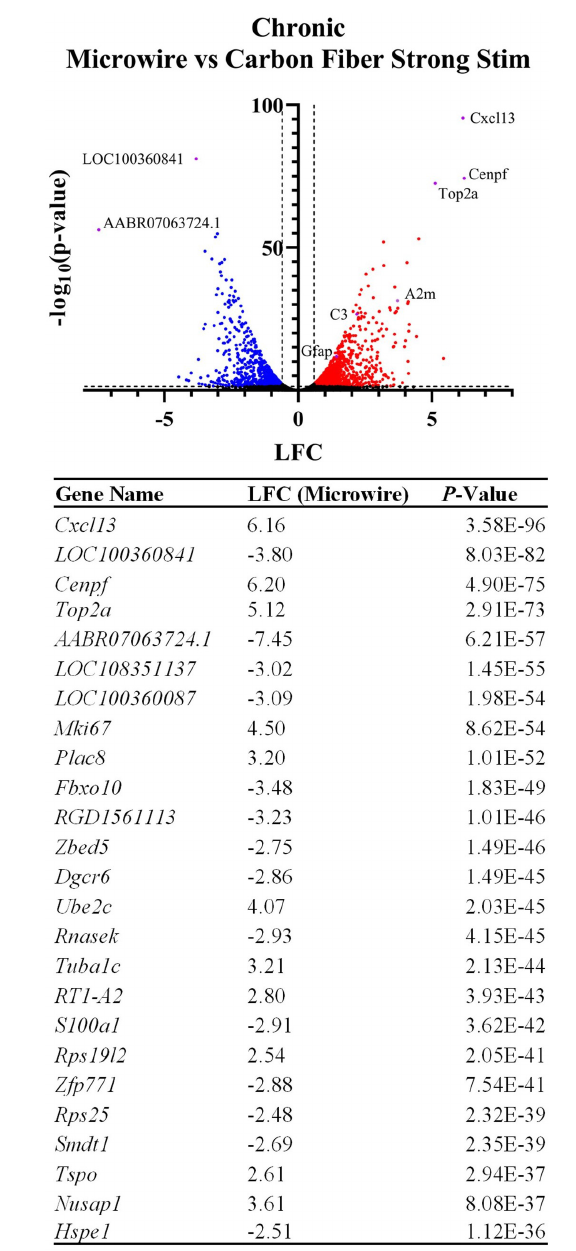
FIGURE 6 | Device type influences the expression of thousands of genes following chronic implantation and electrical stimulation. The volcano plot and table show differentially expressed genes between the two device types delivering a strong electrical stimulation (LFCs indicate differentially expressed genes in MWA relative to HDCF). Genes related to inflammation and cell cycle entry were preferentially upregulated by stimulation delivered by the MWA. The table shows the top 25 most significant DE genes.